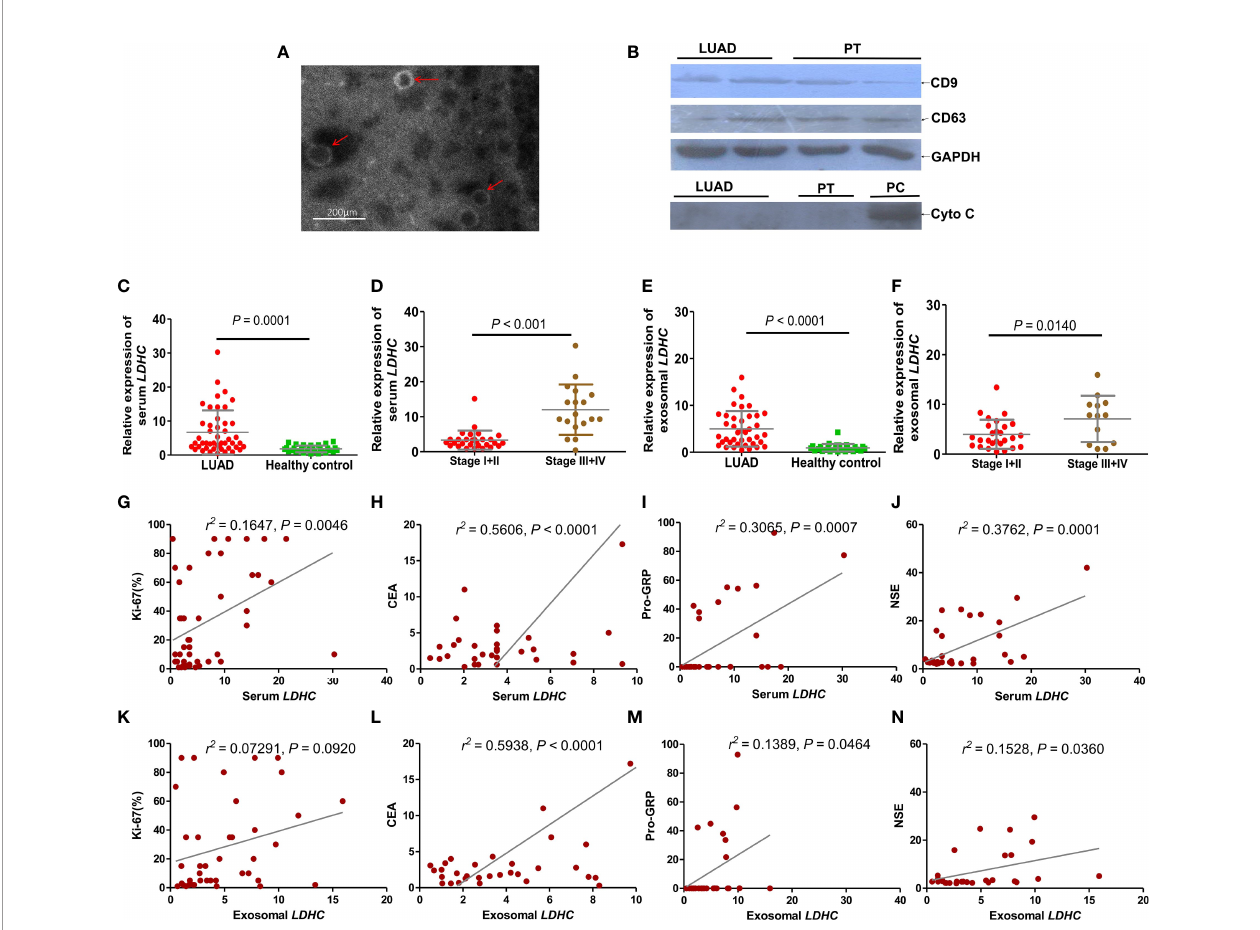
FIGURE 3 | Expression of LDHC in serum and serum-derived exosomes of patients with LUAD and its correlation with clinical molecular markers. (A) Identi fi cation of extracted serum-derived exosome by transmission electron microscopy. The isolated vesicles were indicated by the red arrows. (B) Immunoblotting was used to detect the expression of exosome-related marker proteins. Cyto C (mitochondrial marker) was taken as a negative control to exclude the possible mixture of cellular contamination. PT: paracancerous tissue; PC: positive control using the extracted protein of LDHC downregulated A549 cells. The expression of (C, D) serum and (E, F) serum-derived exosomal LDHC in newly diagnosed LUAD patients and patients with different clinical stages were detected by qPCR. Serum LDHC was positively correlated with the expression of (G) Ki67, (H) CEA, (I) Pro-GRP, and (J) NSE in LUAD patients. Serum-derived exosomal LDHC expression was not correlated with (K) Ki67, but positively correlated with (L) CEA, (M) Pro-GRP, and (N)